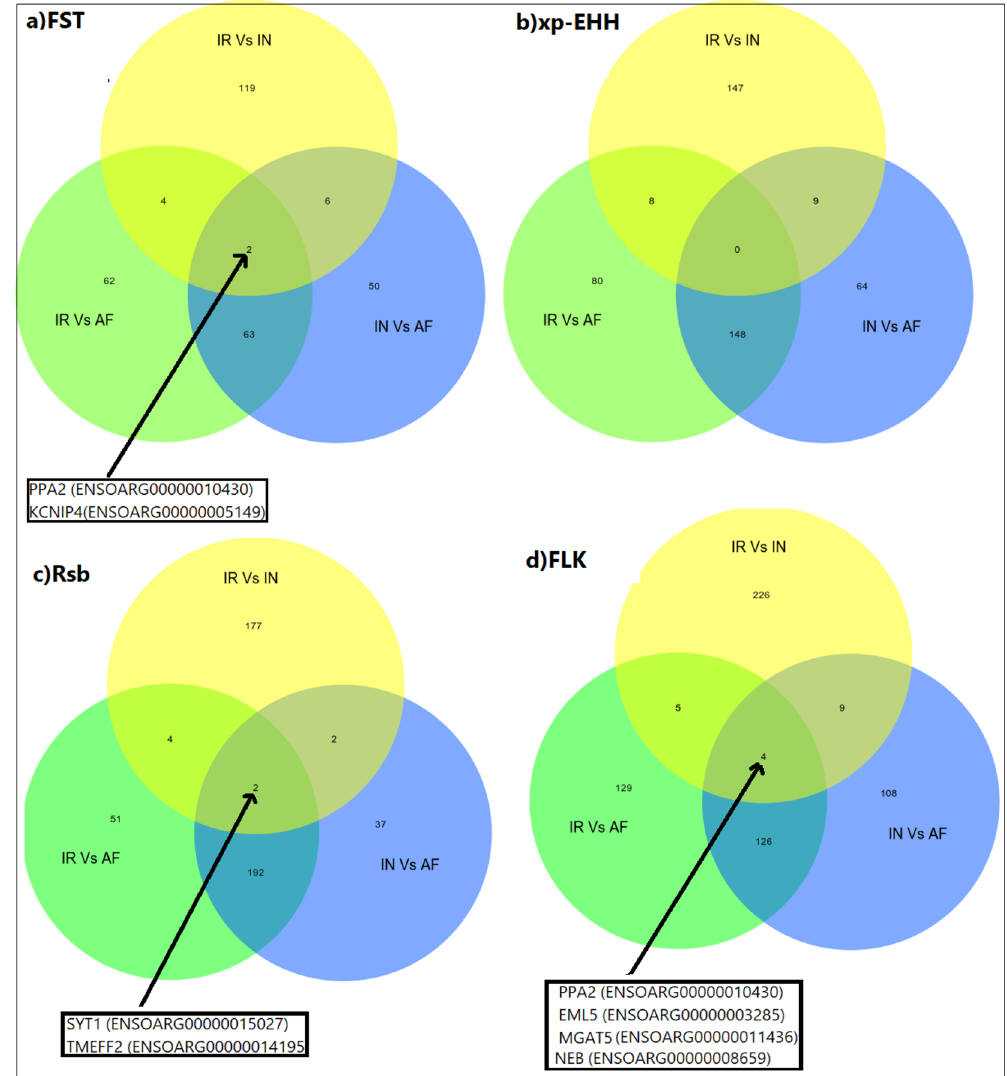
Figure 9. Venn diagram showing the unique and shared candidate genes for IR vs. IN, IR vs. AF, and IN vs. AF data on: ( a ) FST, ( b ) xp-EHH, ( c ) Rsb, and ( d ) FLK tests. For breed abbreviations, see Table